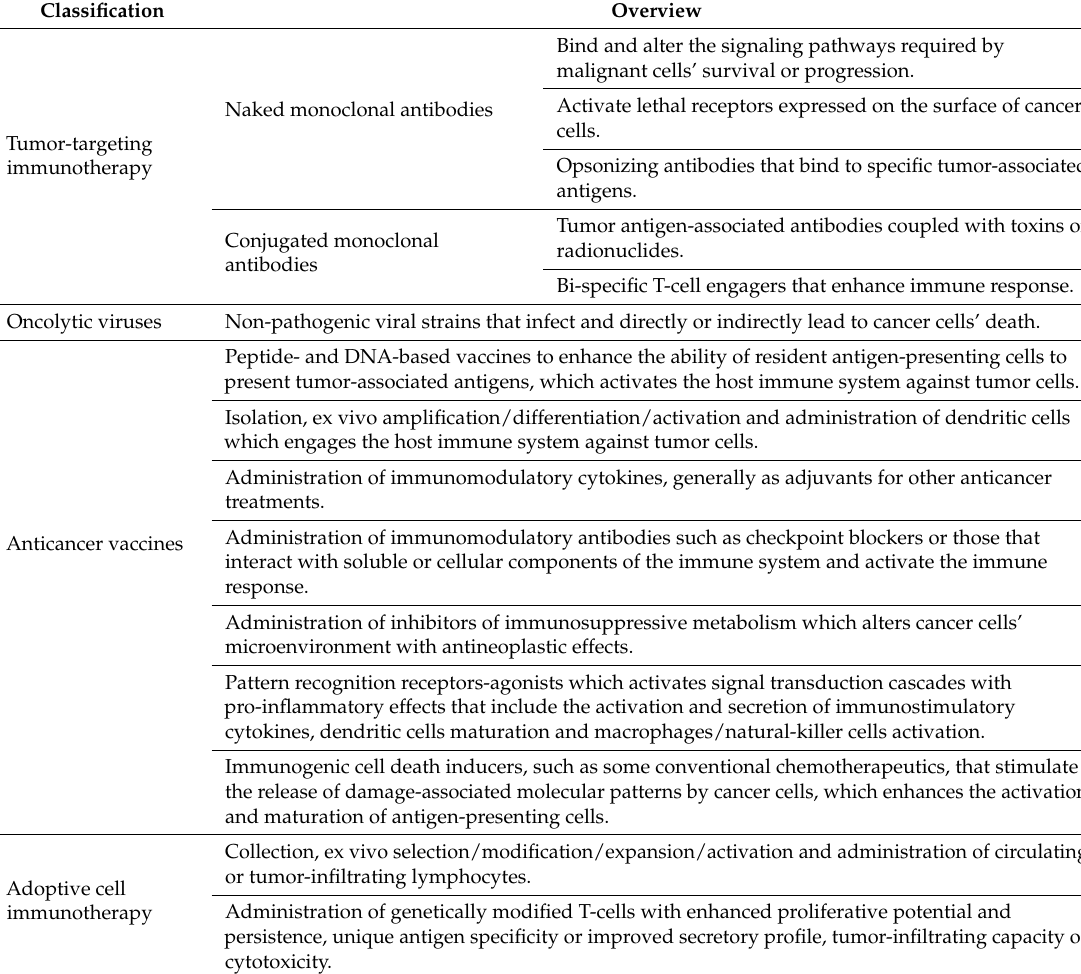
Table 2. Classification of current anticancer immunotherapies